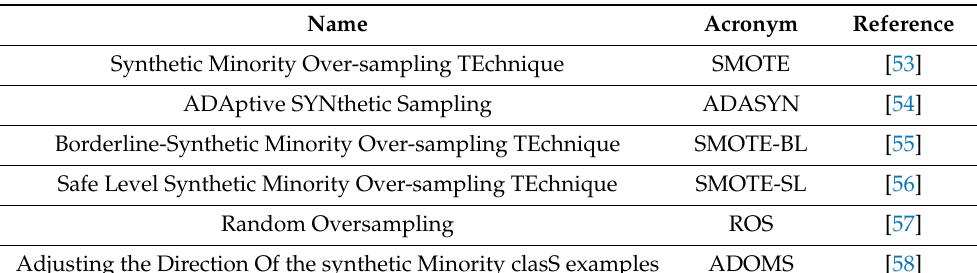
Table 3. Oversampling algorithms used.